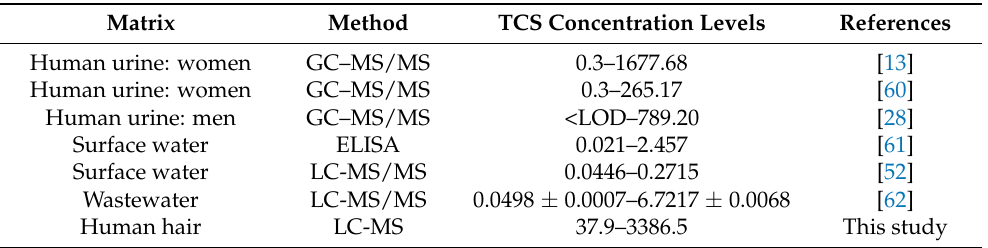
Table 4. TCS in Poland in light of previous studies. Concentrations in ng/mL for liquid samples and in ng/g for solid